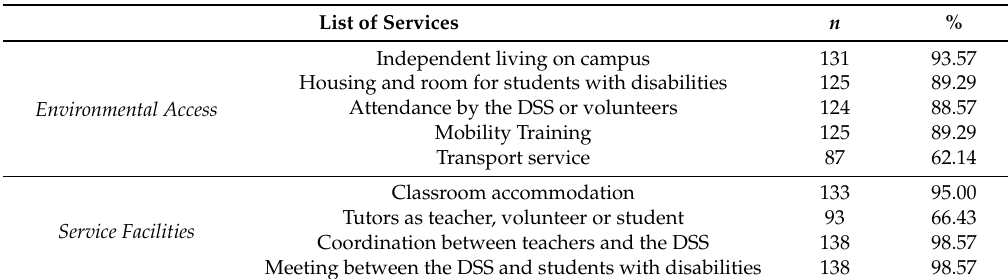
Table 5. Educational services given to students with